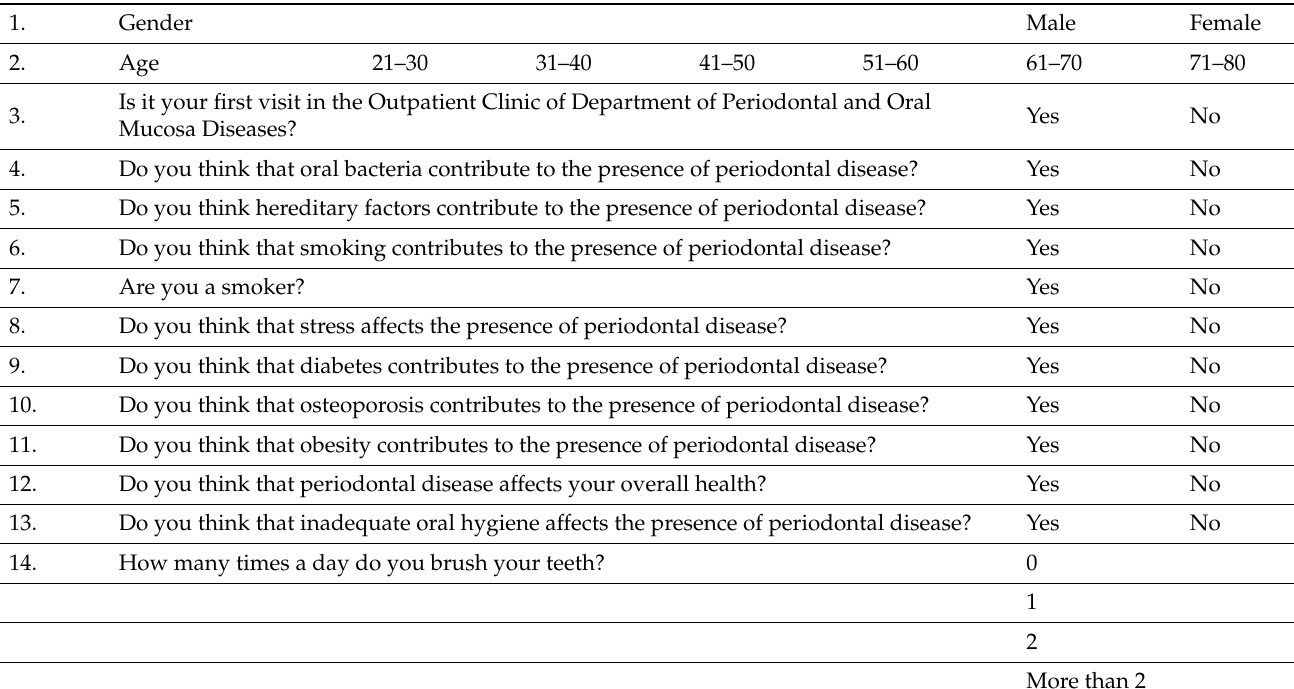
Table 1. Questionnaire administered to